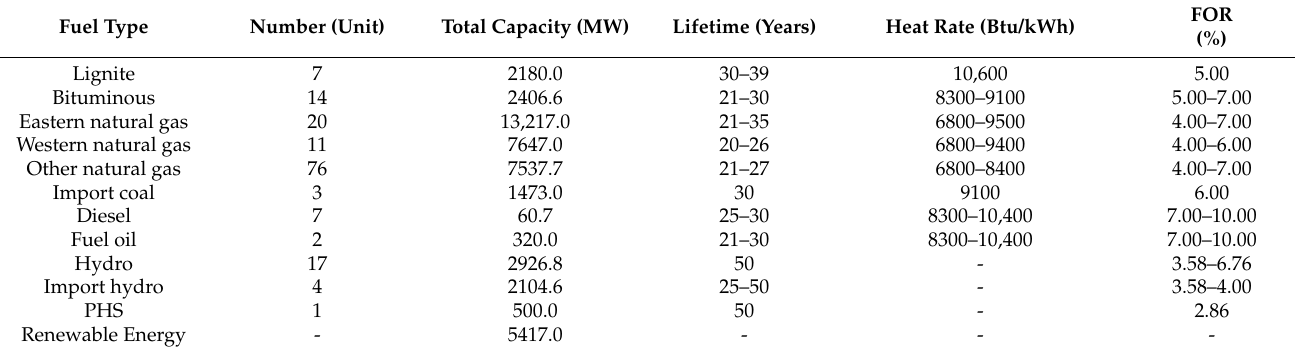
Table A1. Thailand’s power generation system as of December 2017.